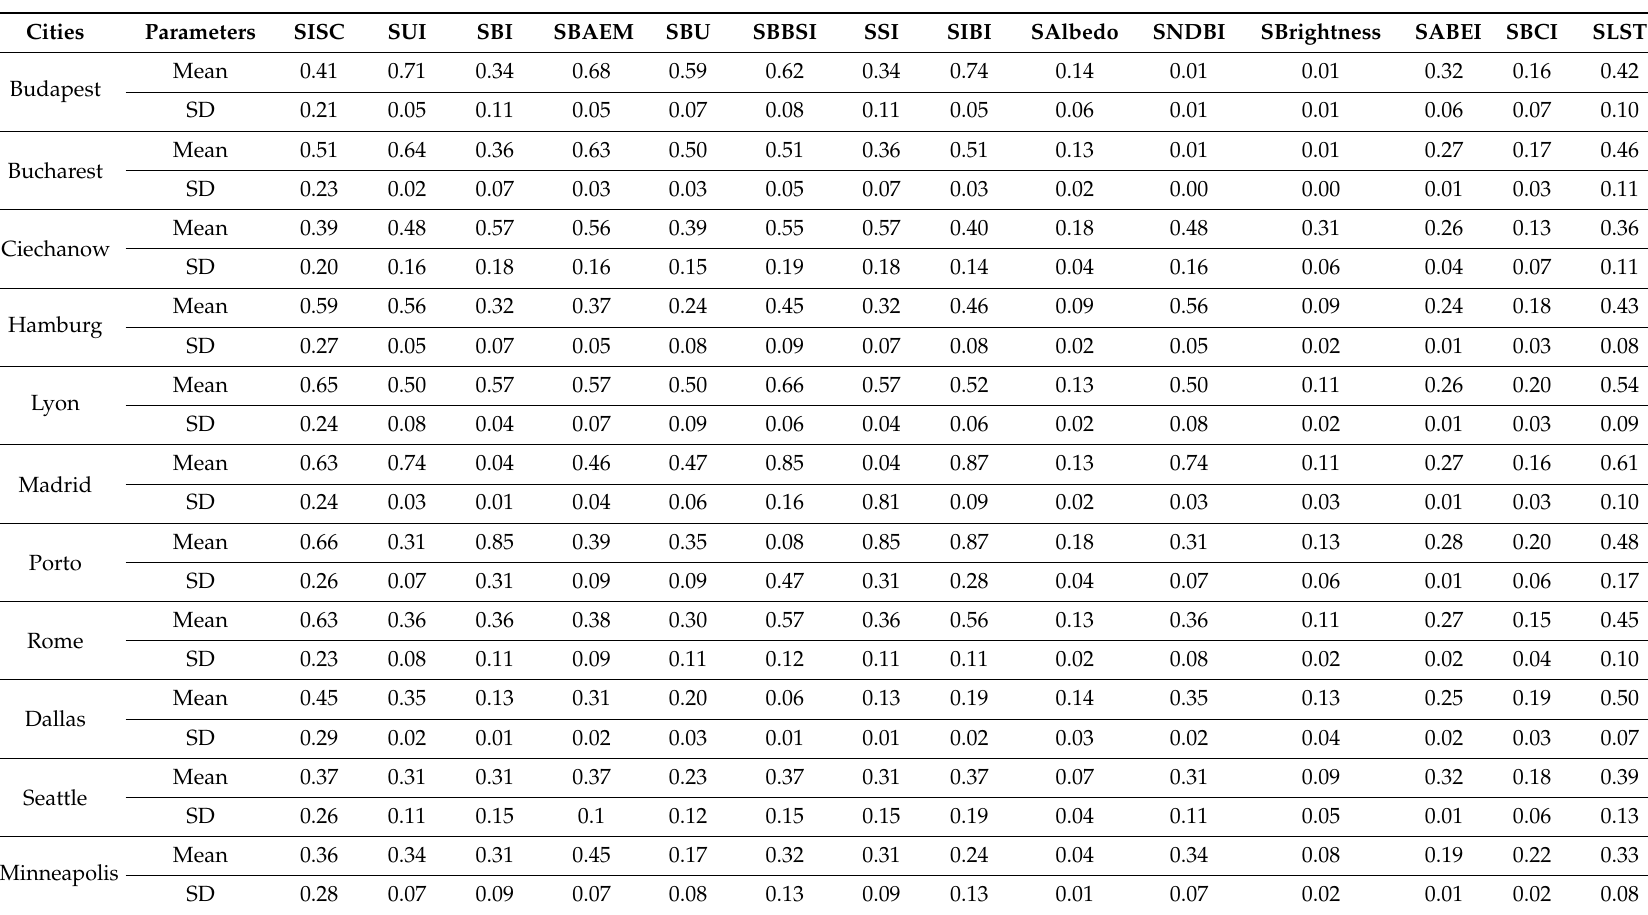
Table 5. The mean value and SD of the di ff erent spectral index values for the selected cities on di ff erent dates. SISC: Standardized Impervious Surface Cover; SUI: Standardized Urban Index; SBI: Standardized Bare Soil Index; SBAEM: Standardized Built-up Area Extraction Method; SBU: Standardized Built-up Index; SBBSI: Standardized Built-up and Bare Soil Index; SSI: Standardized soil index (SI); SIBI: Standardized Index-based Built-up Index; SAlbedo: Standardized Albedo; SNDBI: Standardized Normalized Di ff erence Built-up Index; SBrightness: Standardized Brightness; SABEI: Standardized Automated Built-up Extraction Index; SBCI: Standardized Biophysical Composition Index; SLST: Standardized Land Surface